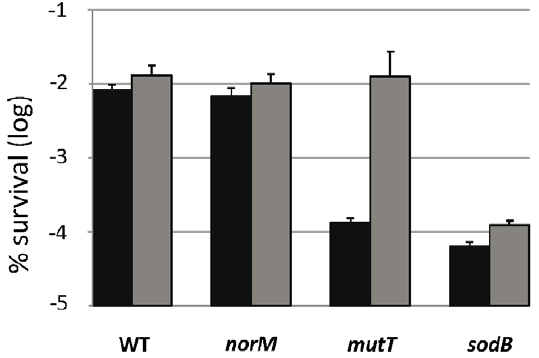
Figure 3. Viability after H 2 O 2 treatment. The data represent survival percentages after 30 min of 50 mM H 2 O 2 treatment. Data for strains NR10831, NR10831 D norM , NR10831 D mutT , and NR10831 D sodB harboring either the empty vector pCA24N (black) or the plasmid expressing norM , pCNorM, (gray) are shown. Survival is represented as the percentage of cfu after H 2 O 2 treatment relative to before treatment. The error bars indicate one standard error of the mean of four independent